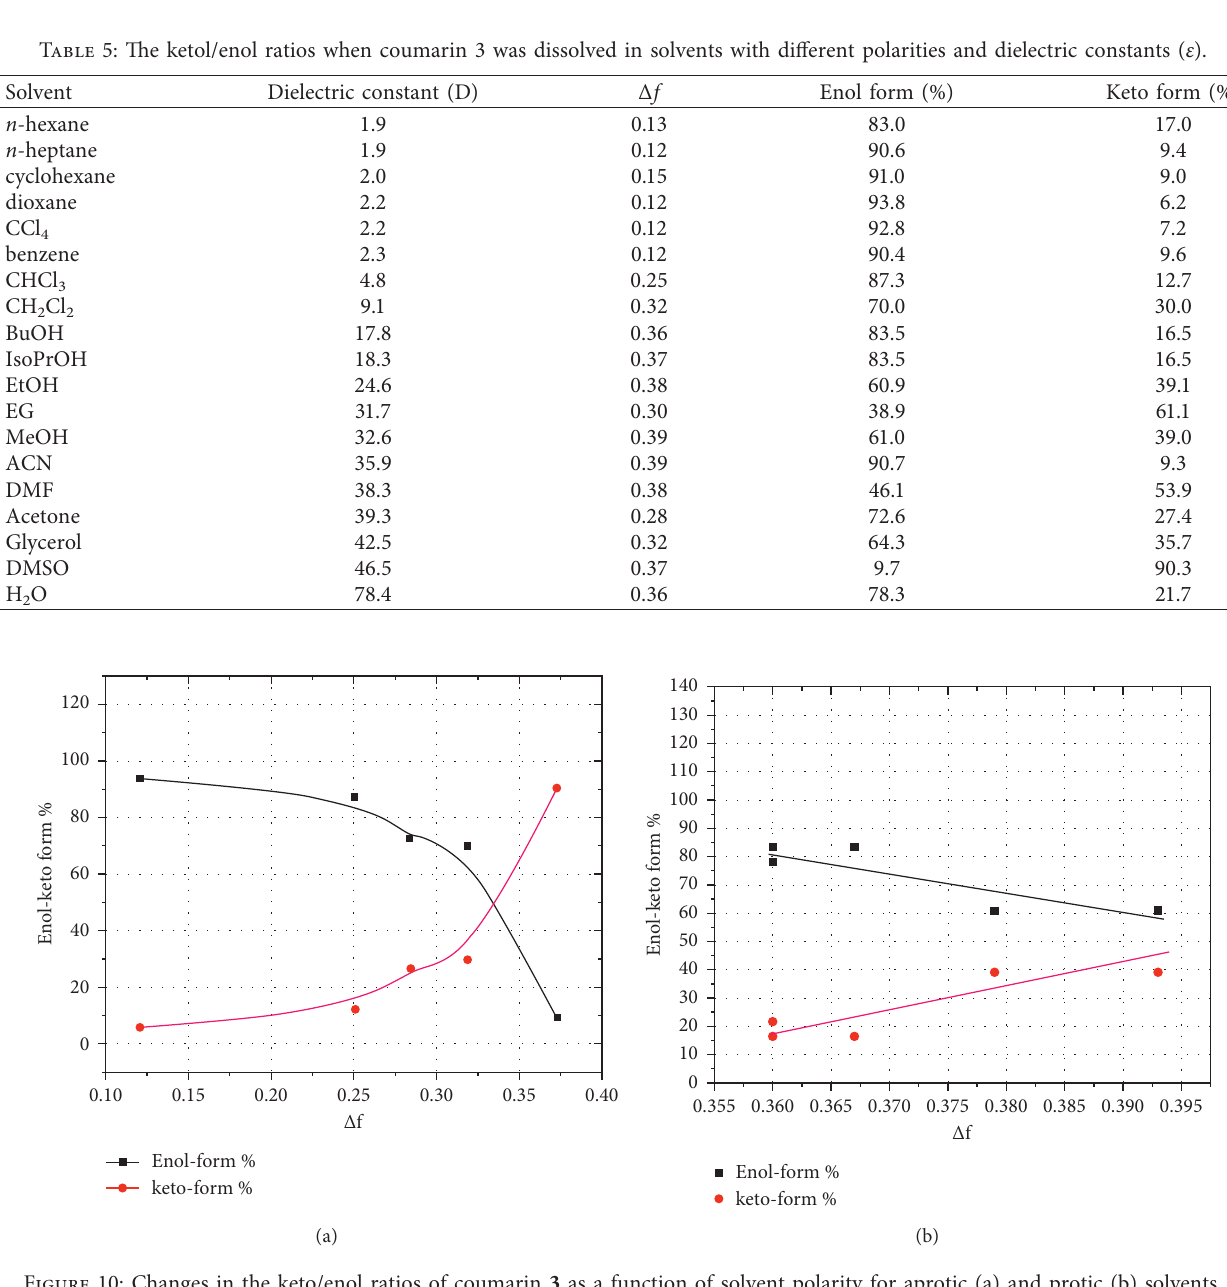
Dipole moment (D)